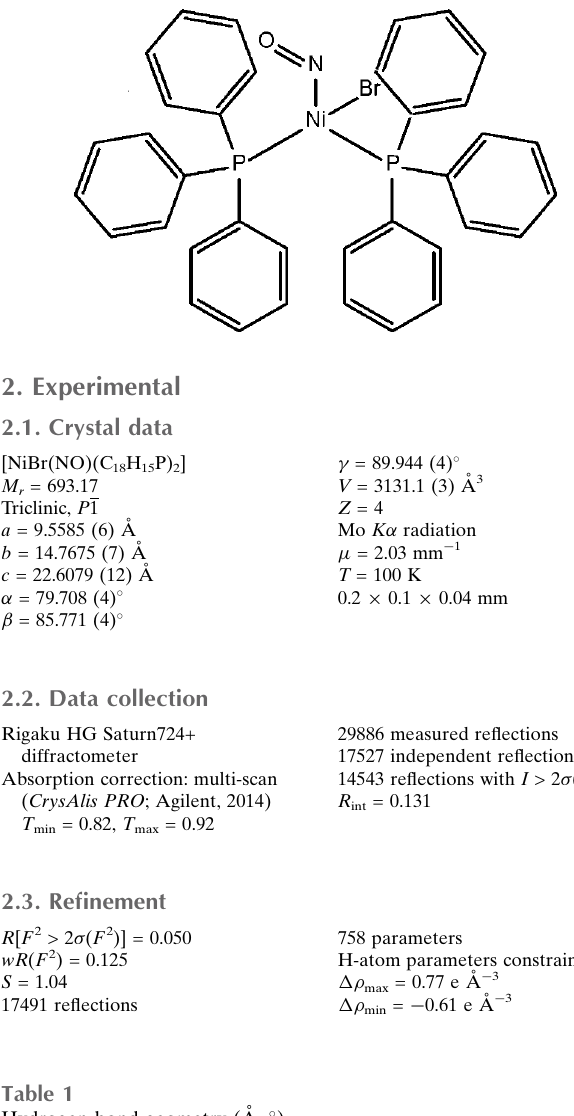
Hydrogen-bond geometry (A˚ , (cid:2)